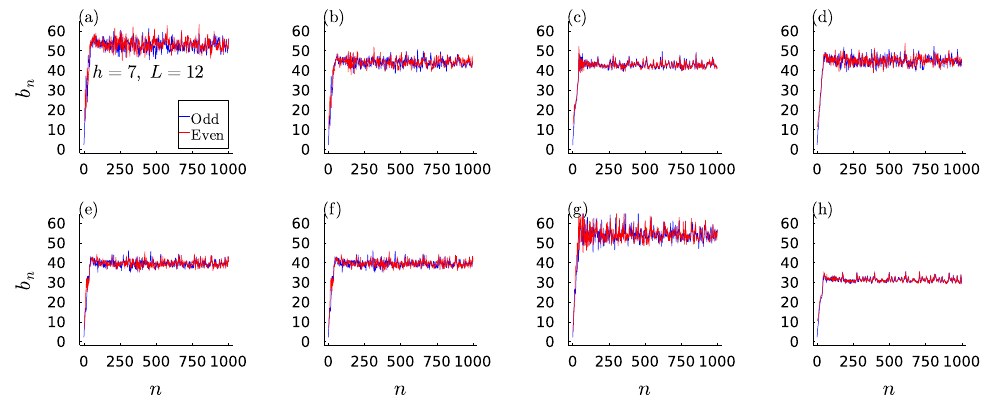
Figure 16: (a)-(h)Disorder realizations of the Lanczos coefficients b h = 7 (MBL regime).